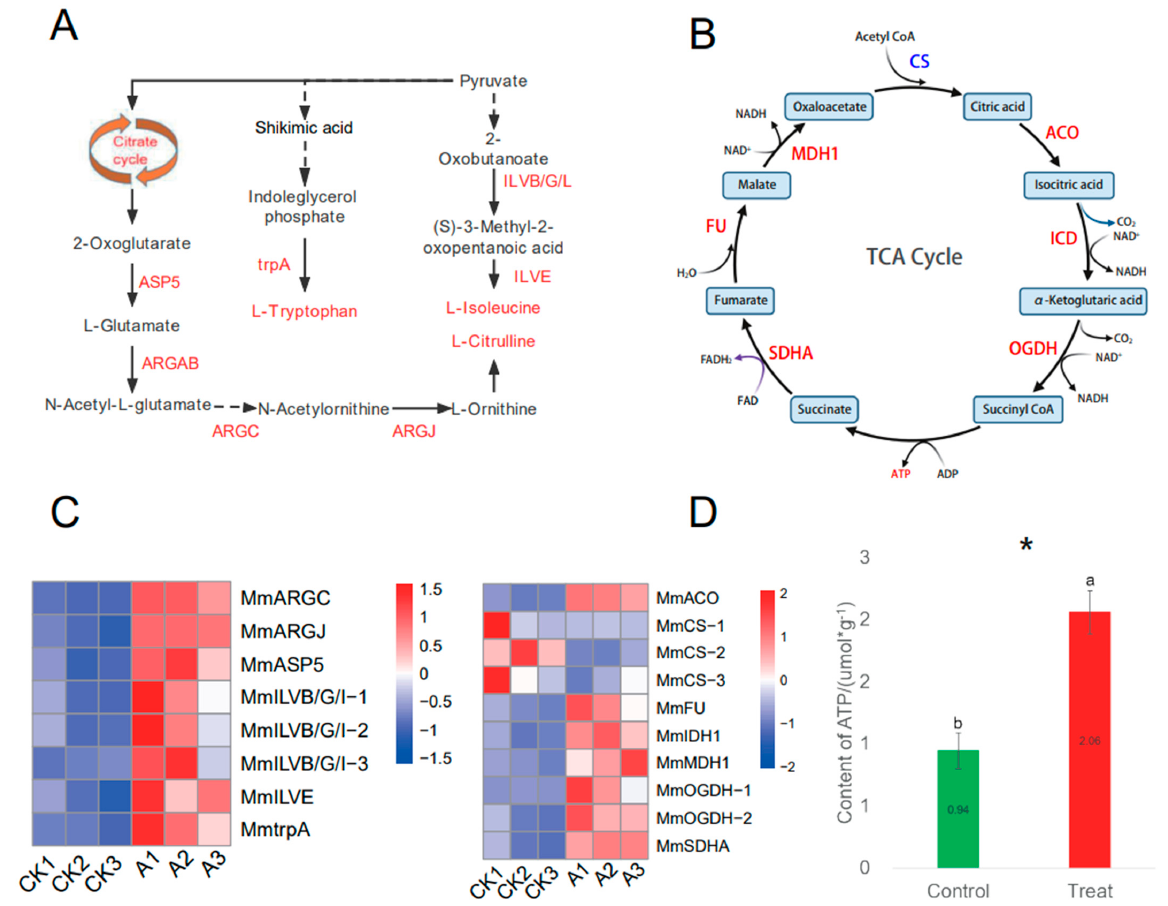
Figure 4. Gene expression and metabolite content of amino acid metabolism and TCA cycle pathway in M. micrantha under P. spegazzinii stress. ( A ) Pathway of amino acid metabolism; ( B ) pathway of the TCA cycle. The gene expression levels were denoted in blue (down-regulated) and red (up-regulated). Metabolite content is represented in blue (down-regulated) and red (up-regulated). ( C ) Expression pattern of key amino pathway genes in M. micrantha ; ILVB/G/L: acetolactate synthase I/II/III large subunit; IMS: 2-isopropylmalate synthase; trpA: tryptophan synthase alpha chain; ILVE: branched-chain amino acid; ARGJ: glutamate N-acetyltransferase; ARGC: N-acetyl-gamma-glutamyl- phosphate reductase; ARGAB: amino-acid N-acetyltransferase; ASP5: aspartate aminotransferase, chloroplastic. Expression pattern of key TCA cycle genes in M. micrantha ; SDHA: succinate de- hydrogenase (ubiquinone) flavoprotein subunit; FU: fumarate hydratase, class II; MDH1: malate dehydrogenase 1; CS: citrate synthase; ACO: aconitate hydratase; ICD: isocitrate dehydrogenase; OGDH: 2-oxoglutarate dehydrogenase E1 component. ( D ) Changes in the contents of ATP by the P. spegazzinii infection; Significant differences are indicated according to Student’s t test: *, p < 0.05. The error bars represent the means ±